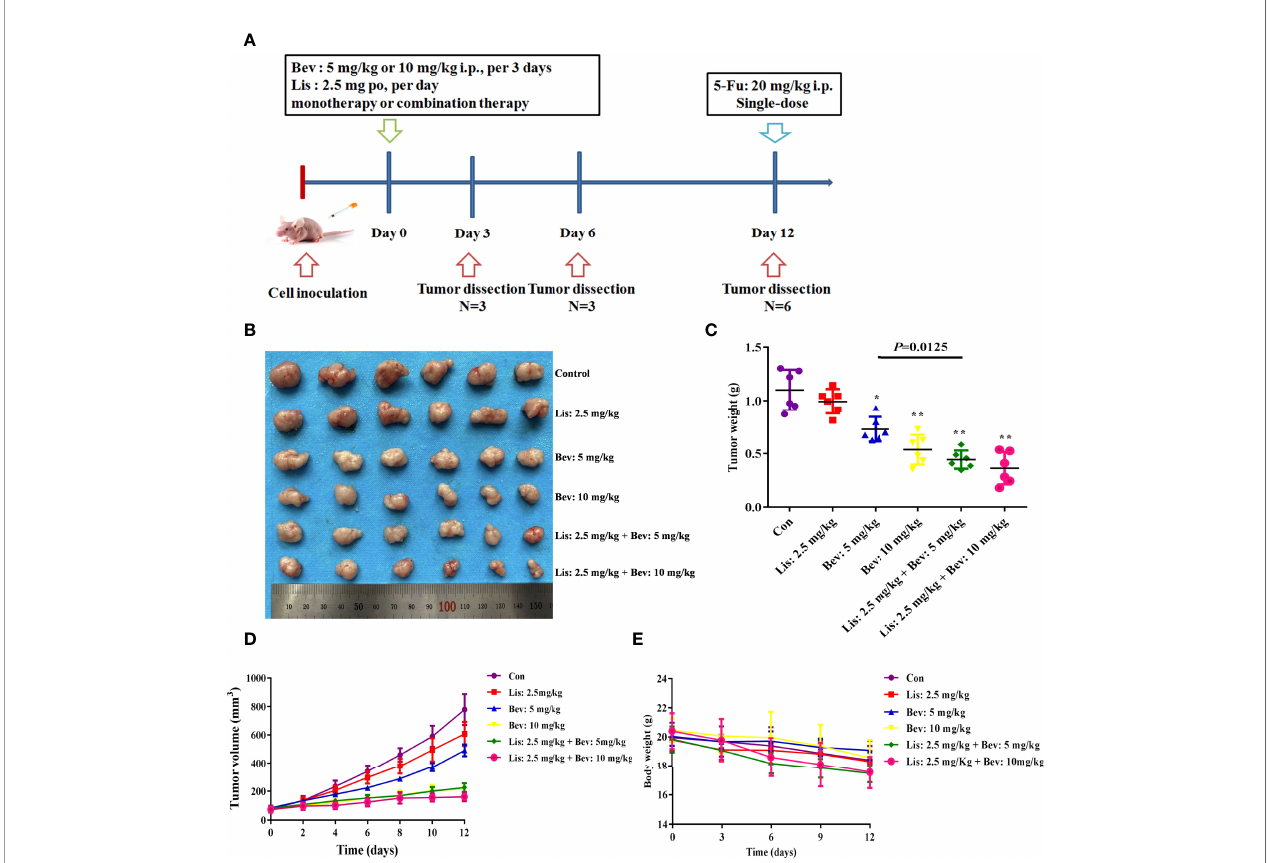
FIGURE 2 | Bev and Lis synergistically inhibit tumor growth in HCT116 xenografts. (A) Schematic of the study design. BALB/c nude mice were subcutaneously injected in the bilateral fl ank with HCT116 cells. The mice were treated with Bev at 5 mg/kg or 10 mg/kg by intraperitoneal injection every 3 days and/or Lis at 2.5 mg/kg orally once daily. (B) Images of tumors excised from the mice (n = 6). (C) Means of the tumor weights. (D) Tumor growth curves were generated by measuring tumor volumes every 2 days. (E) Means of the mouse weights. Data represent the mean ± SEM. * P < 0.05, ** P < 0.01 versus the control group. Con, control; Bev, bevacizumab; Lis, lisinopril; 5-Fu, 5- fl